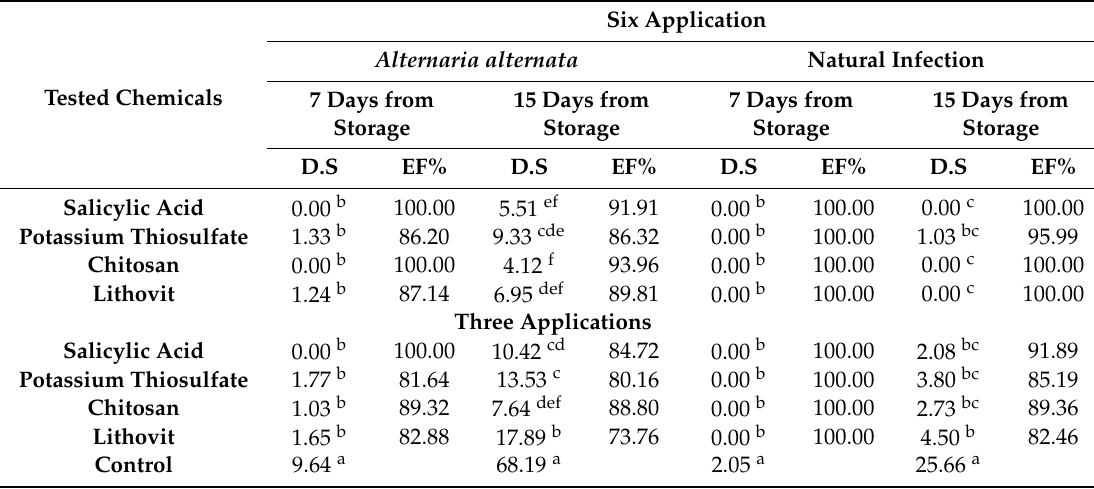
Table 4. The e ff ect of tested chemicals as pre-harvest foliar applications on tomato black rot during storage under cold conditions during season 2018.